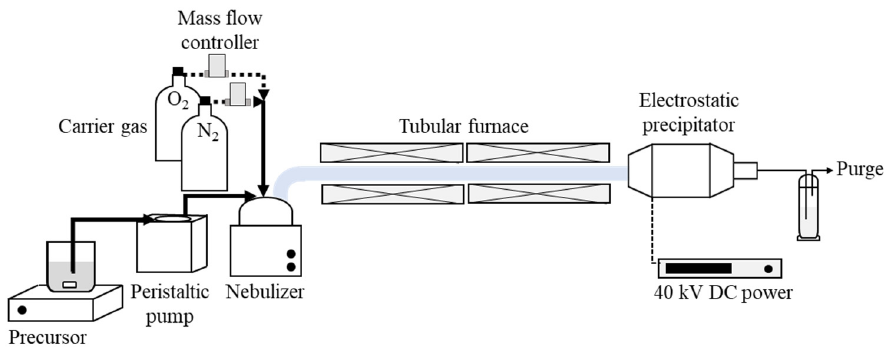
Figure 10. Experimental setup of the nanoparticle synthesis using a spray pyrolysis method. ZnO ‐ Ag nanocomposites were fabricated by adding silver nitrate (AgNO 3 , 99.5%, E. Merck, D ‐ 6100 Darmstadt, FR Germany) at concentrations of 1, 5, and 10 wt% to the zinc